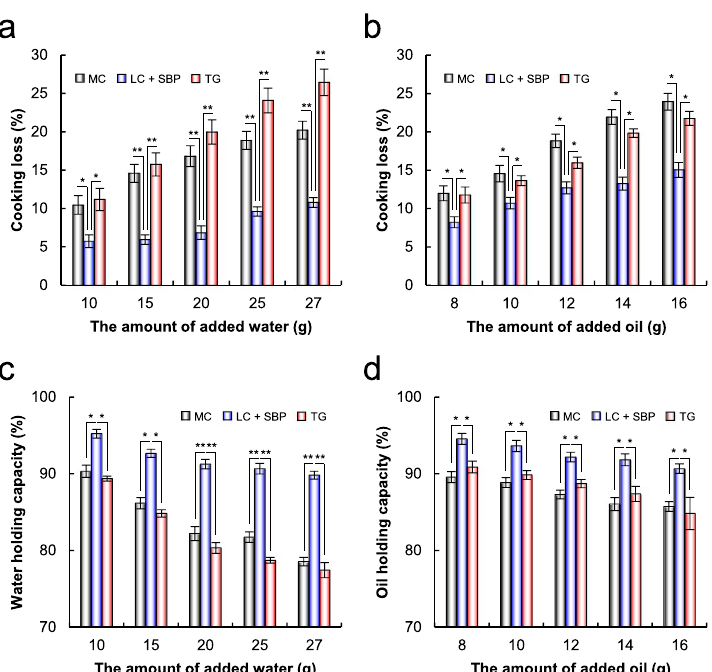
Figure 4. Cooking loss value and water/oil holding capacity of meat analogs. ( a , b ) Cooking loss was calculated as the percentage weight difference between the dough before cooking and after cooking. Meat analog containing different amounts of water ( a ) or oil ( b ) was treated with LC and cooked. ( c , d ) Holding capacity was calculated by comparing the weight of meat analogs before and after centrifugation. Meat analog patties containing different amounts of water ( c ) or oil ( d ) was treated with LC, cooked, and centrifuged. * p < 0.05, ** p < 0.01, Student’s t -test. MC, meat analog containing MC; LC + SBP, LC-treated meat analog containing SBP; TG, TG-treated meat